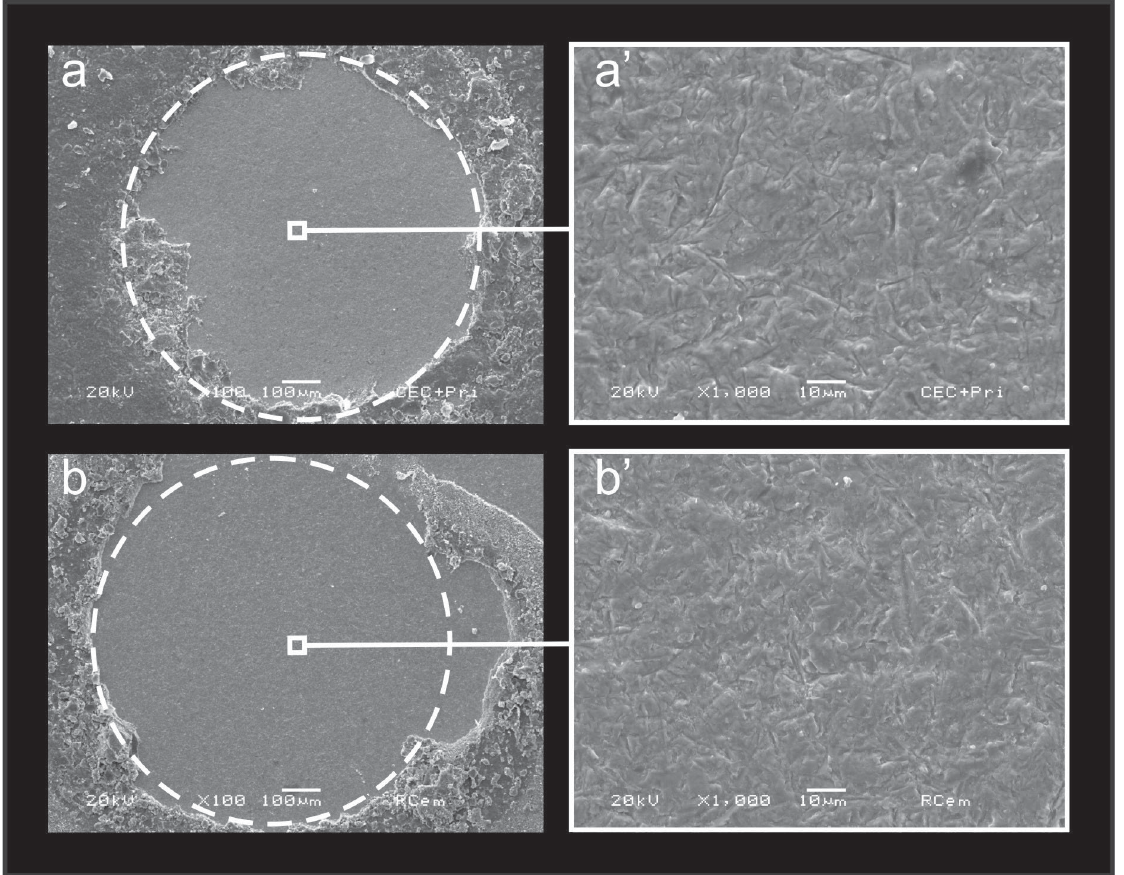
Fig. 2. SEM micrographs. In images a and b adhesive failures can be seen in the Clearfil Esthetic Cement with ceramic primer (G3) and ResiCem (G2), respectively. The circle shows the original position of specimens. Images a’ and b’ (higher magnification) show details of the adhesive failure on the zirconia surface after the ìsbs